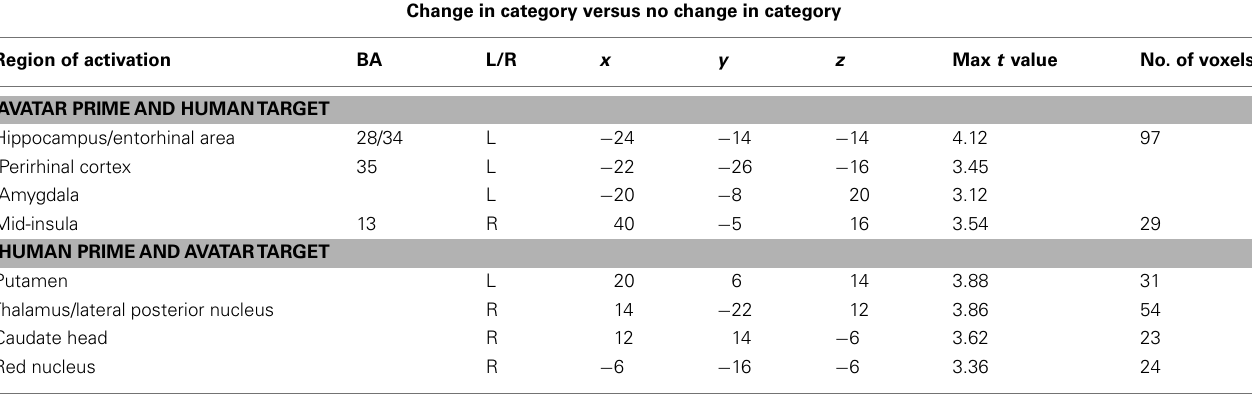
Table 2 | Brain areas sensitive to category change.